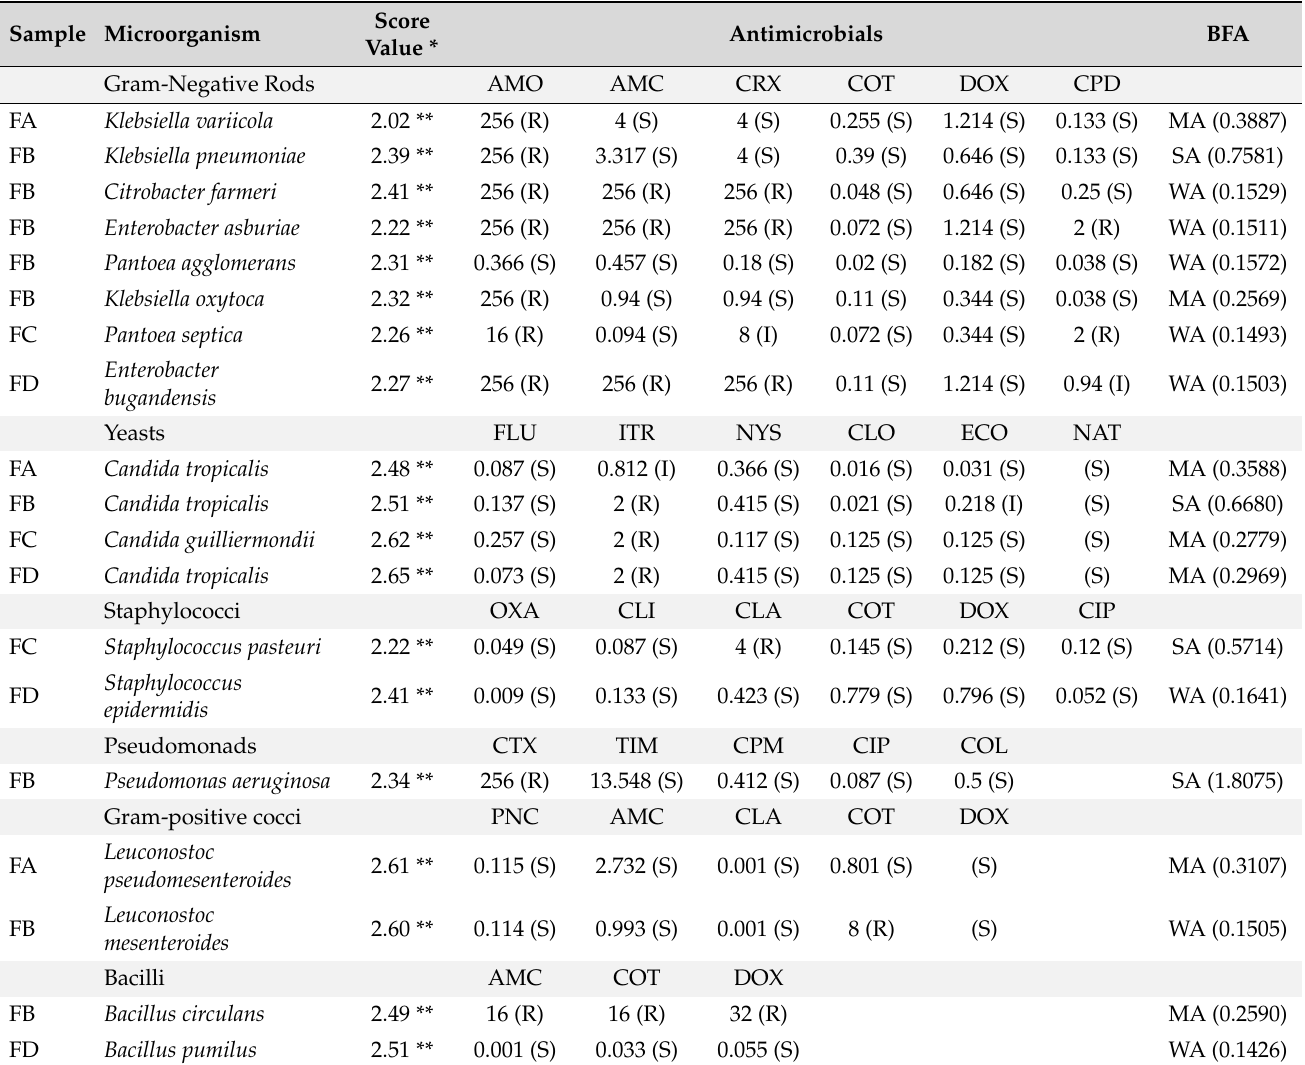
Table 4. Identified microorganisms isolated from fruit smoothie drink samples with their biofilm formation ability and susceptibility to antimicrobials expressed as minimum inhibitory concentra- tion ( µ